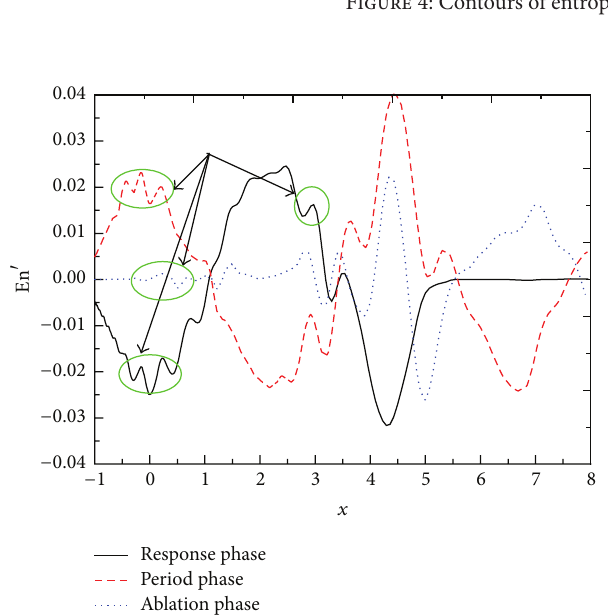
Figure 5: Distribution of entropy disturbance En 󸀠 (𝑥,𝑦, 𝑡) on